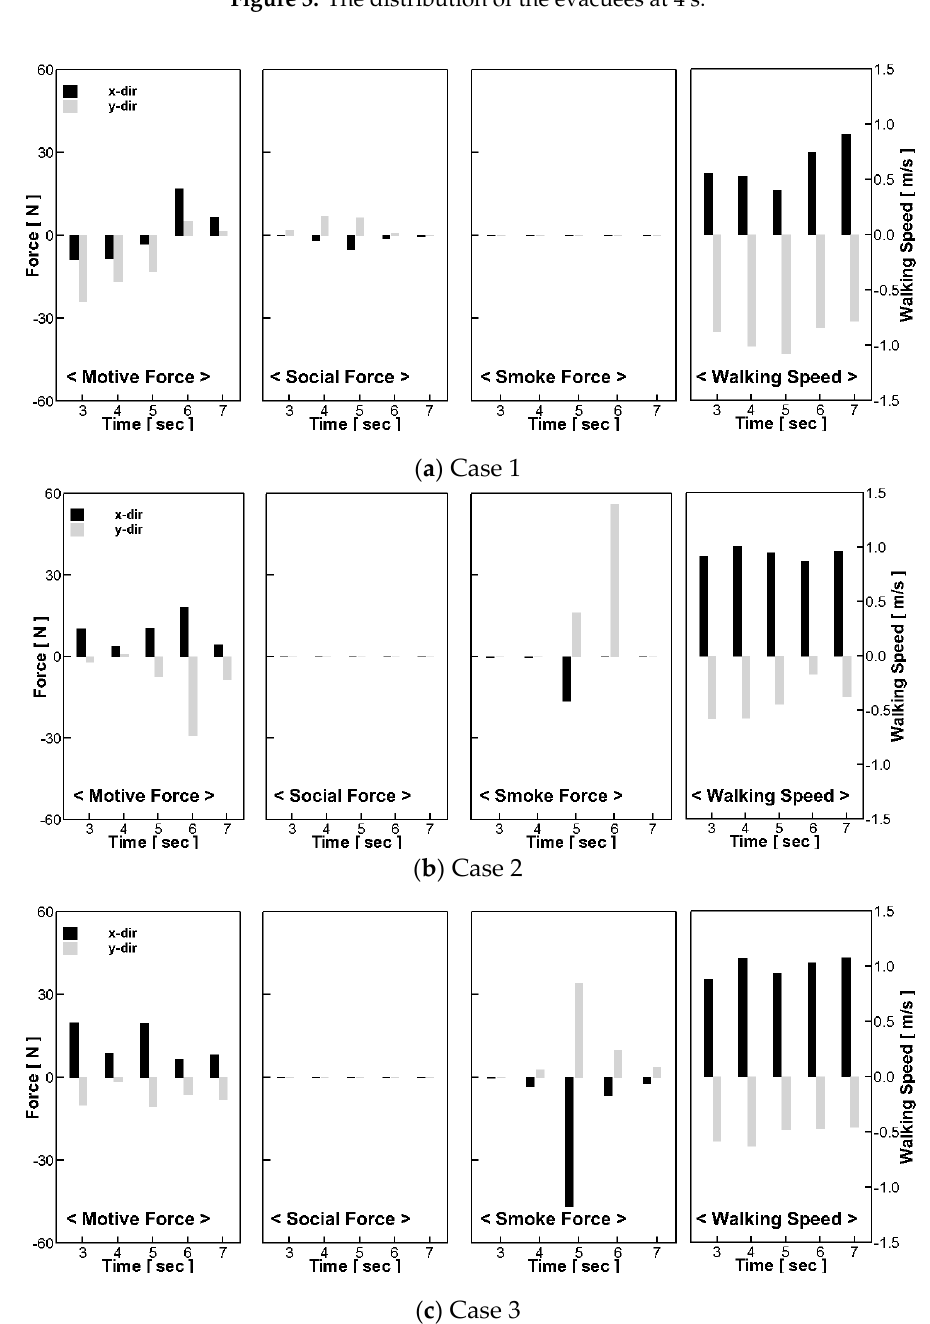
Figure 4. The forces acting on the representative evacuee and the walking speed from 3 to 7 s.